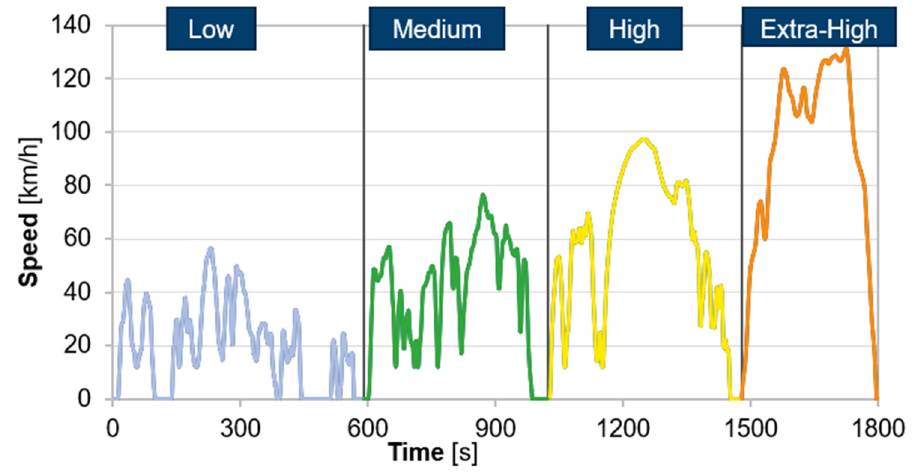
Figure 2. WLTC Class 3b with different driving scenarios (adapted from [42]).